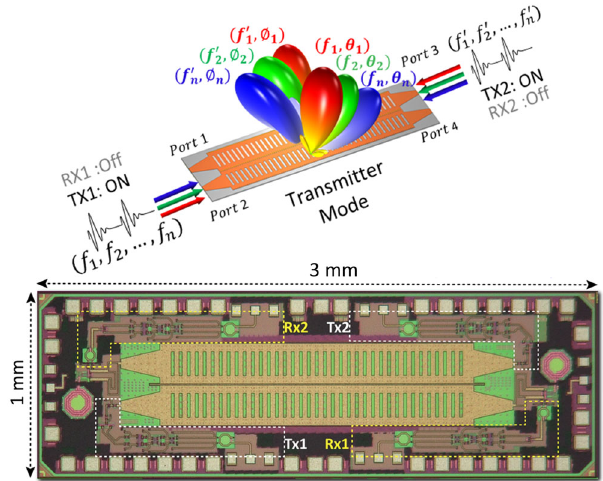
Fig. 6 | CMOS leaky-wave emitter. An integrated circuit, fabricated in silicon CMOS, which realizes a leaky-wave antenna for single-shot localization of multiple users in a broadcast sector via broadband excitation of the angularly dispersive aperture. Figureadapted from H.Saeidi,S.Venkatesh, X. Lu and K. Sengupta,"THz Prism:One-ShotSimultaneousLocalizationofMultipleWirelessNodesWithLeaky- Wave THz Antennas and Transceivers in CMOS," in IEEE Journal of Solid-State Cir- cuits, vol. 56, no. 12, pp. 3840-3854, Dec. 2021, https://doi.org/10.1109/JSSC.2021. 3115407.withpermissionoftheauthorsunderaCreativeCommonslicense:https:// creativecommons.org/licenses/by/4.0.